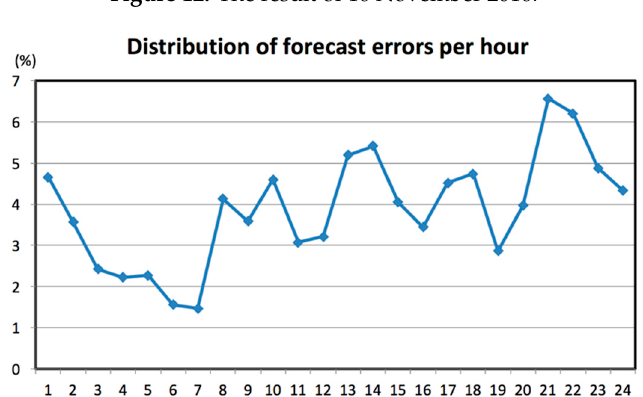
Figure 12. The result of 16 November 2016. Energies 2019 , 12 , x FOR PEER REVIEW